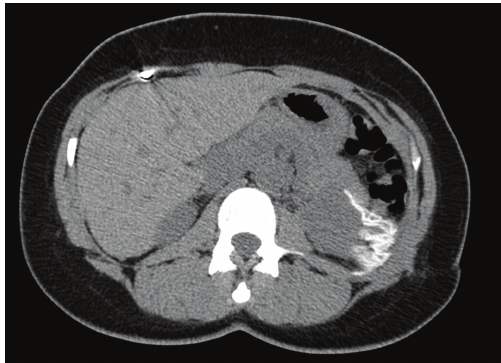
Figure 2: Postoperative CT abdomen demonstrating PTFE bolster on left kidney.